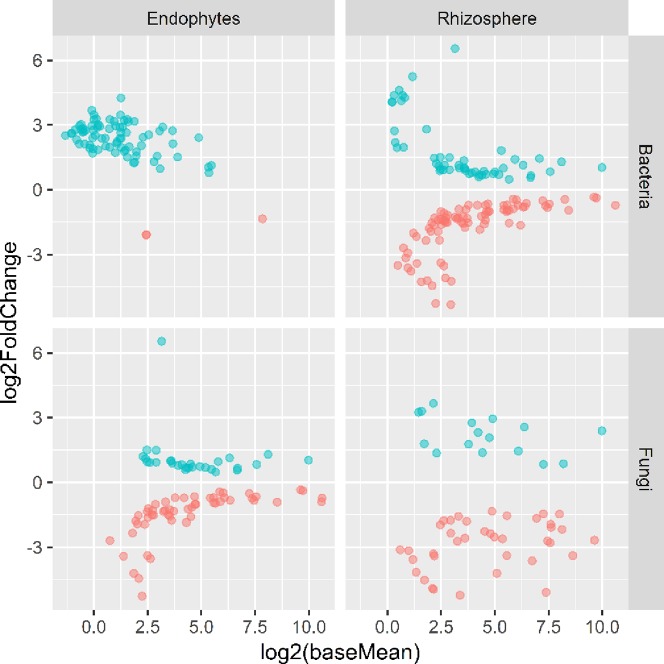
Plots of DeSeq2 analysis results for OTUs with significant (P < 0.05) differences between the wilt resistant and susceptible cultivars; baseMean is the average number of sequence reads for each OTU and log2FoldChange is the loge of the ratio in the number of sequence reads between the wilt resistant and susceptible cultivars. The blue symbols (positive log2FoldChange) indicates that the relative abundance of specific OTUs was greater in the wilt resistant cultivar samples than in susceptible cultivar samples.